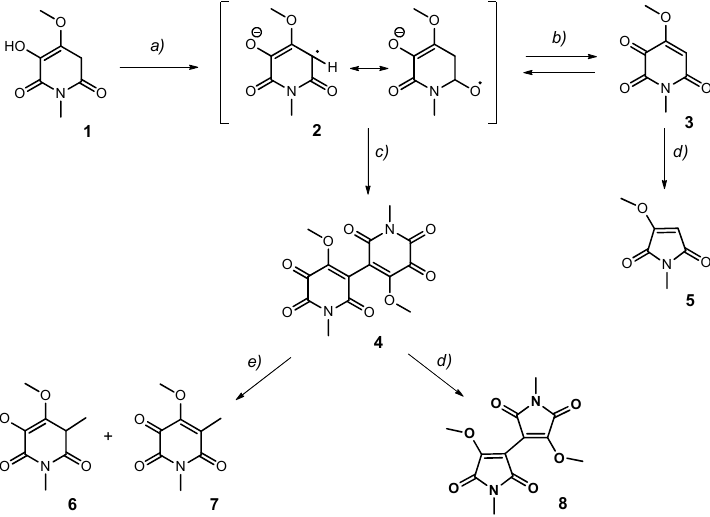
Figure 1. Proposed metabolic pathway of hermidin ( 1 ). Conversion by oxidation ( a–c ) and catabolization ( e–d ) upon the action of LAB. ( a ) Deprotonation and oxidation (-2H + ; –e – ). ( b ) Oxidation (–e – ). ( c ) Dimerization and protonation ( + 2H + ). ( d ) Benzilic acid rearrangement and oxidative decarboxylation (–CO 2 , –2H + ). ( e ) Partial six-ring degradation.